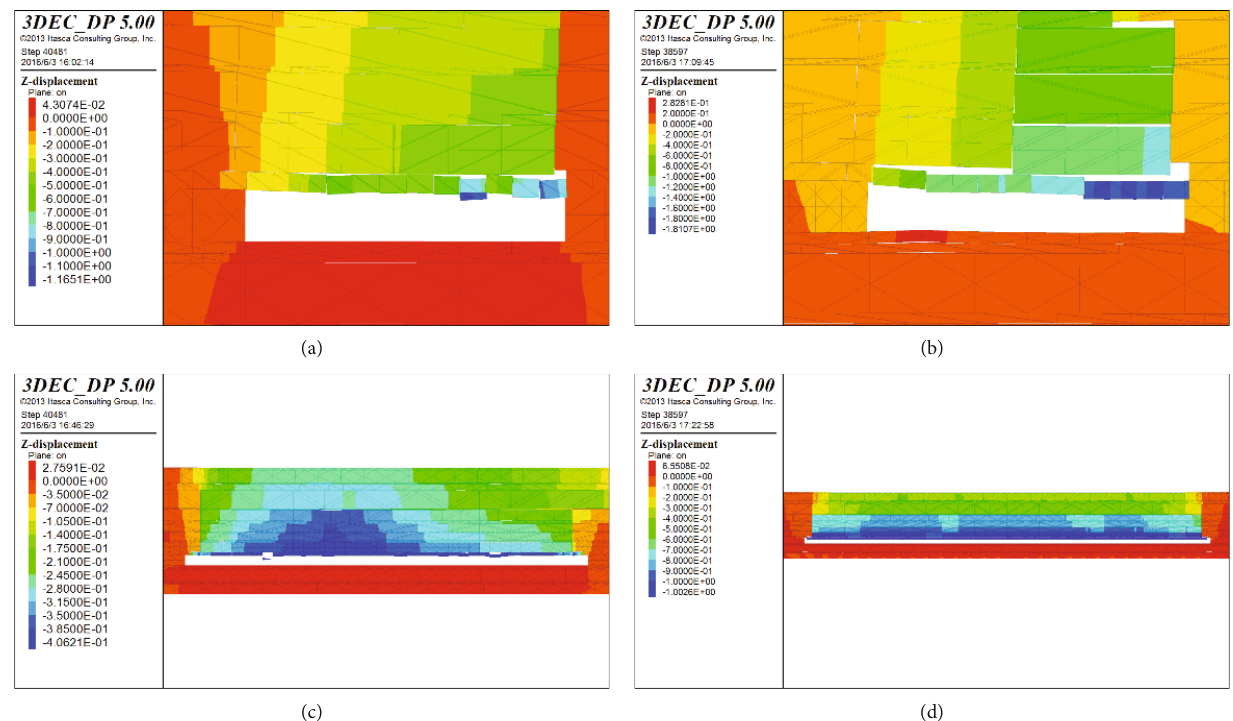
Figure 6: Nephogram of roof strata displacement when advancing to 35 m(unit: m): (a) slice of the 195m working face in advancing direction, (b) slice of the 376m working face in advancing direction, (c) lengthwise slice of the 195m working face, and (d) lengthwise slice of the 376m working face.